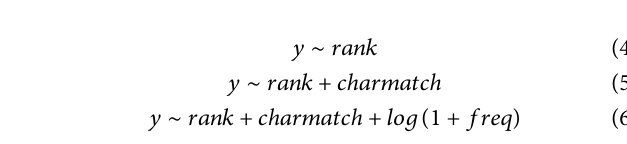
Frontiers in Arti fi cial Intelligence |